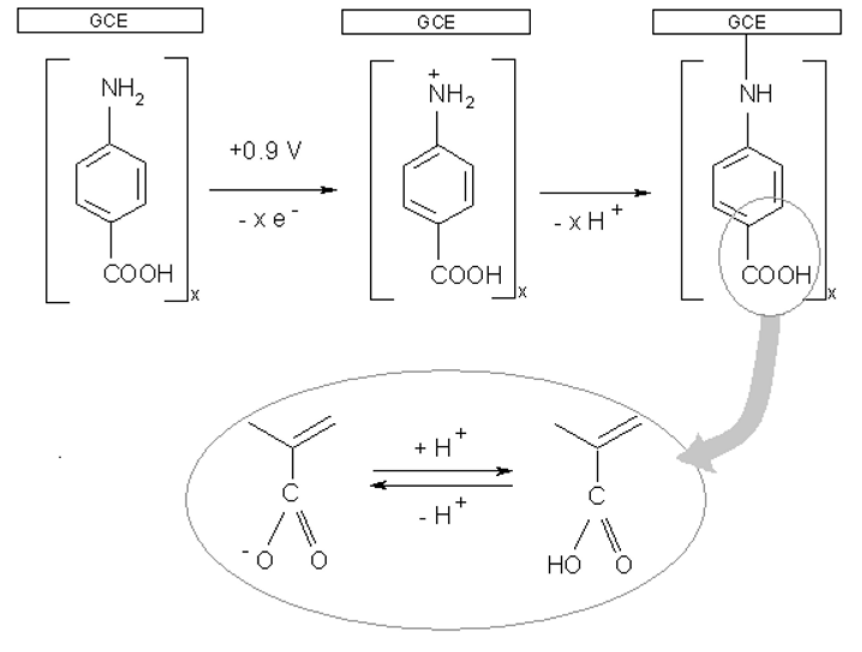
Figure 1. Grafting of 4-ABA on GCE